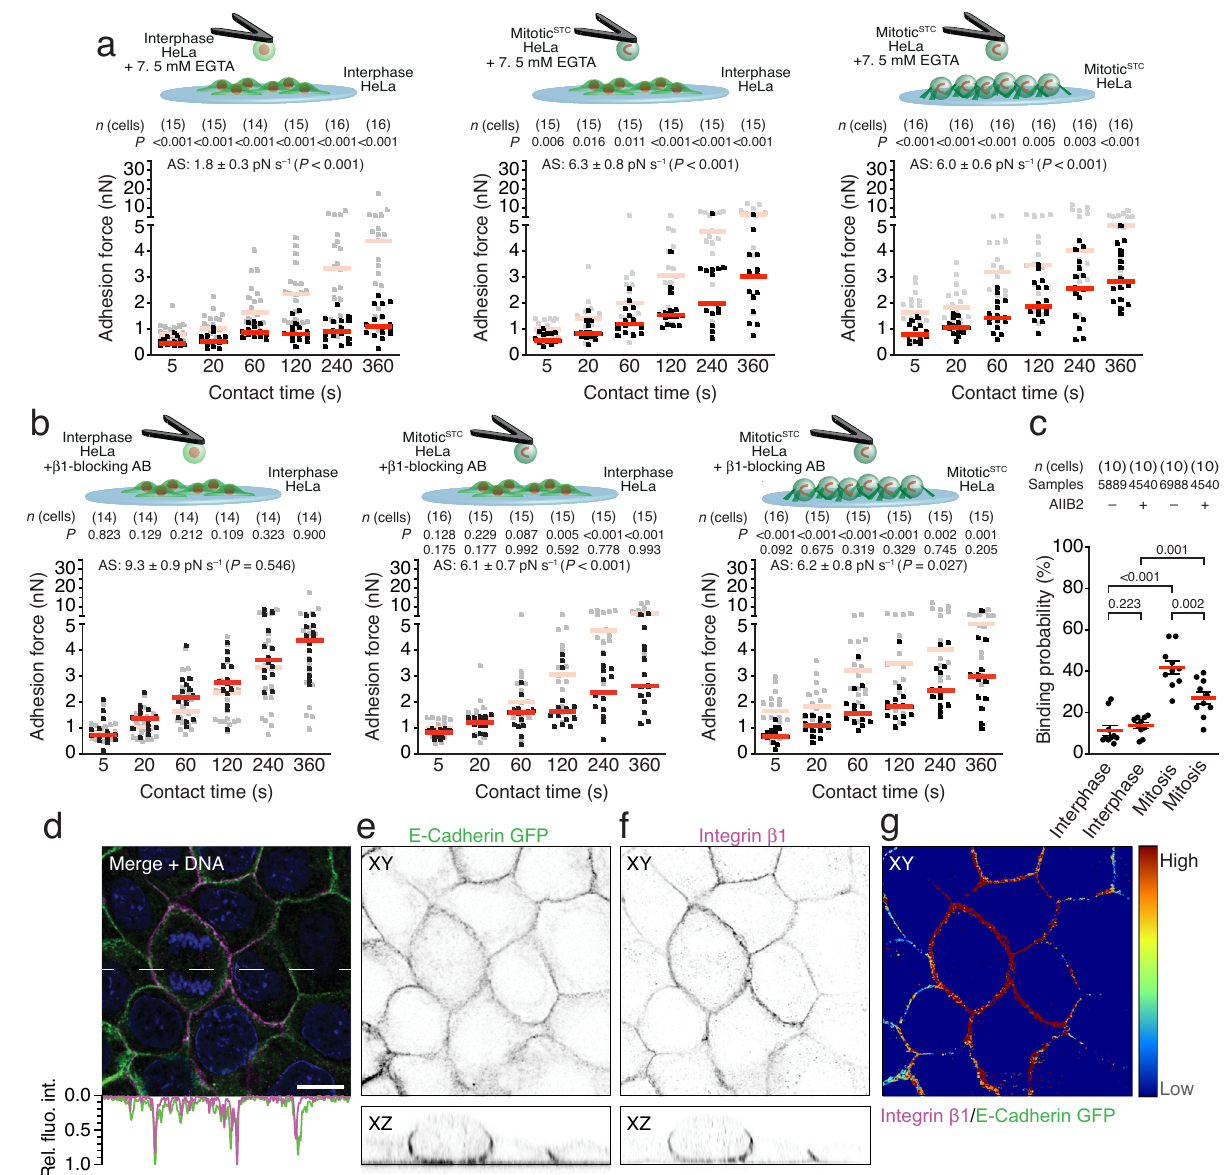
Fig. 8 | β 1 integrins promote mitotic cell – cell adhesion. a Adhesion forces between two interphase (left), mitotic STC and untreated interphase HeLa cells (middle) or two mitotic STC HeLa cells (right) the presence of EGTA. b Adhesion forces between an AIIB2-treated and untreated interphase (left), AIIB2-treated mitotic STC and untreated interphase (middle) or AIIB2-treated and untreated mitotic STC (right) HeLa cells. Dots represent adhesion forces between single cantilever-boundandsubstrate-spreadcells,redbarstheirmediansand n (cells)the number of independent cells in at least three independent experiments. As refer- enceadhesionforcesestablishedbetweentwowildtypeHeLacellsintherespective condition are given in gray (Fig. 1g). The second row P -values compare displayed adhesion forces with adhesion forces between TKO HeLa cells and wildtype HeLa cells in the same conditions (Fig. 4b). The adhesion strengthening rate (AS) is the slope (±SE) of a linear fi t through adhesion forces for all contact times with the P -value comparing the AS-value to the reference data set (Supplementary Figs. 9 and 10). c Binding probability of untreated (data taken from Fig. 2e) or AIIB2- treated interphase and mitotic STC HeLa cells to untreated interphase HeLa cells.